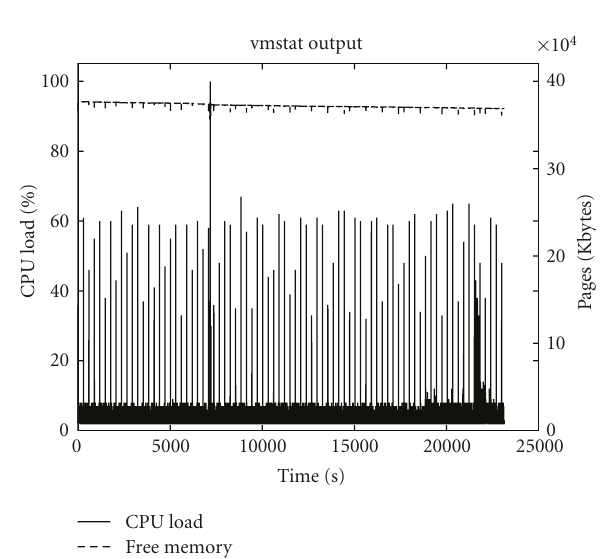
Figure 22: CPU and memory